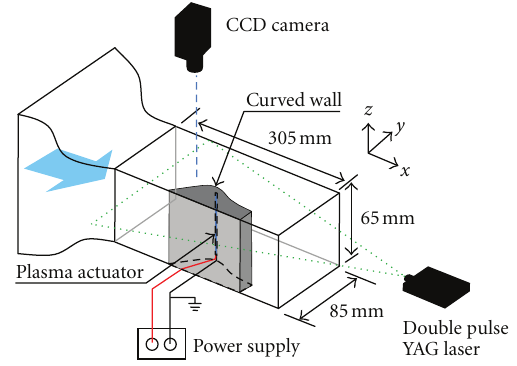
Figure 2: Measurement system.